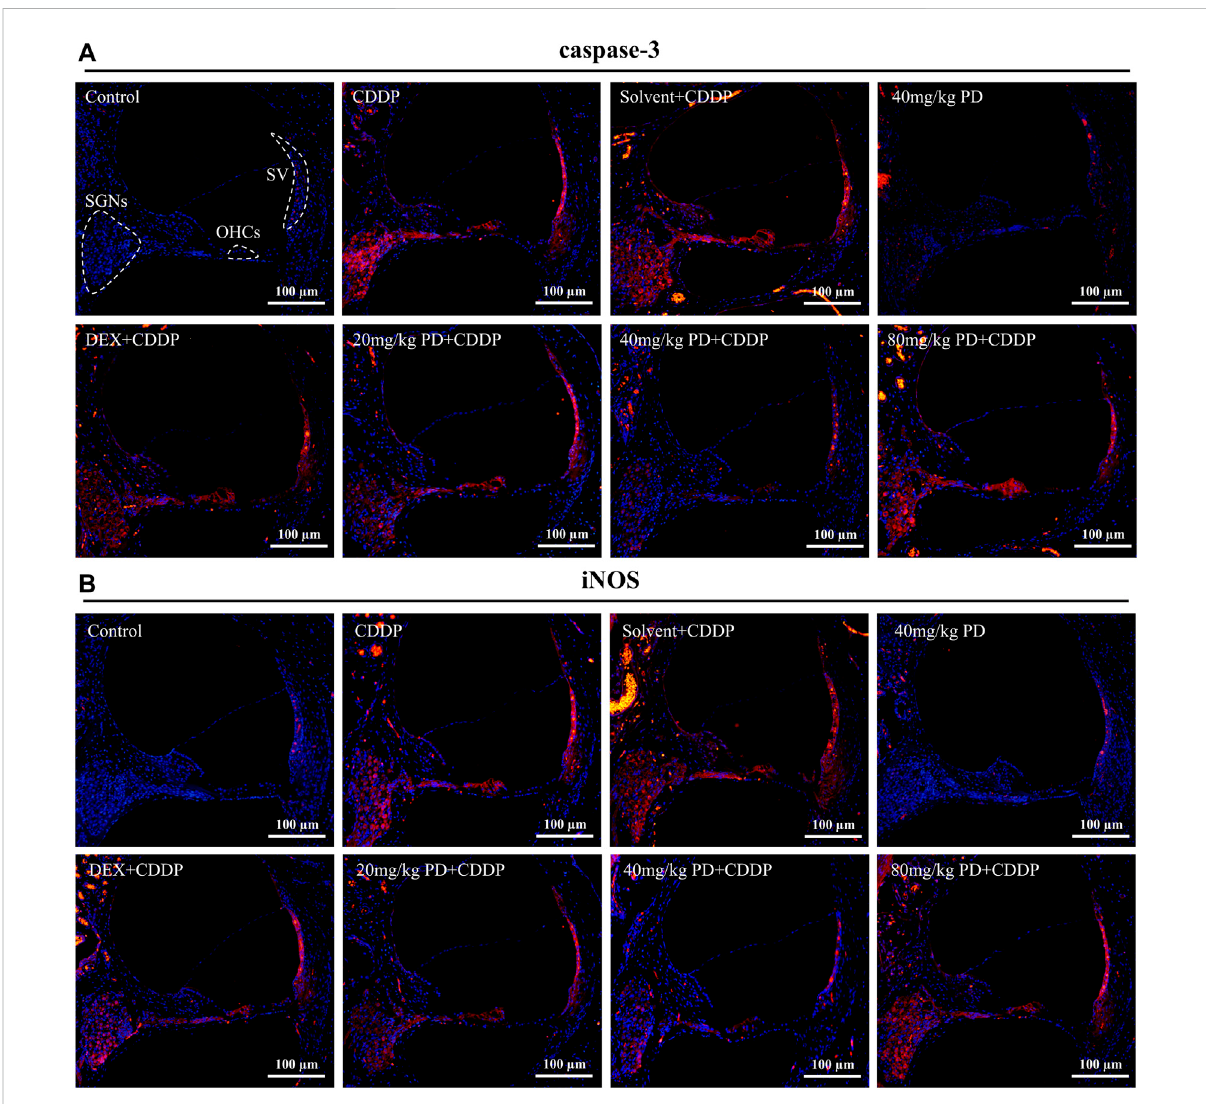
FIGURE 6 PDreducesoxidativestressinjuryandapoptosisinducedbycisplatin.Representativeimmuno fl uorescencelabellinginthecochleaforcaspase- 3 [red, (A) ] and iNOS [red, (B) ], double stained with DAPI in blue. The three dotted areas are SGNs, OHCs and SV. (A,B) Under normal circumstances, caspase-3 and iNOS were barely expressed in SGNs, OHCs and SV. However, apoptosis and oxidative stress damage occurred in cells in the three regions after cisplatin administration, accompanied by high expression of caspase-3 and iNOS, and marked increase in red fl uorescence intensity. PD and DEX before cisplatin administration reduced oxidative stress damage and cell apoptosis in the cochlea, showing that the red fl uorescence intensity was lower than that of the CDDP group. Scale bar, 100 μ